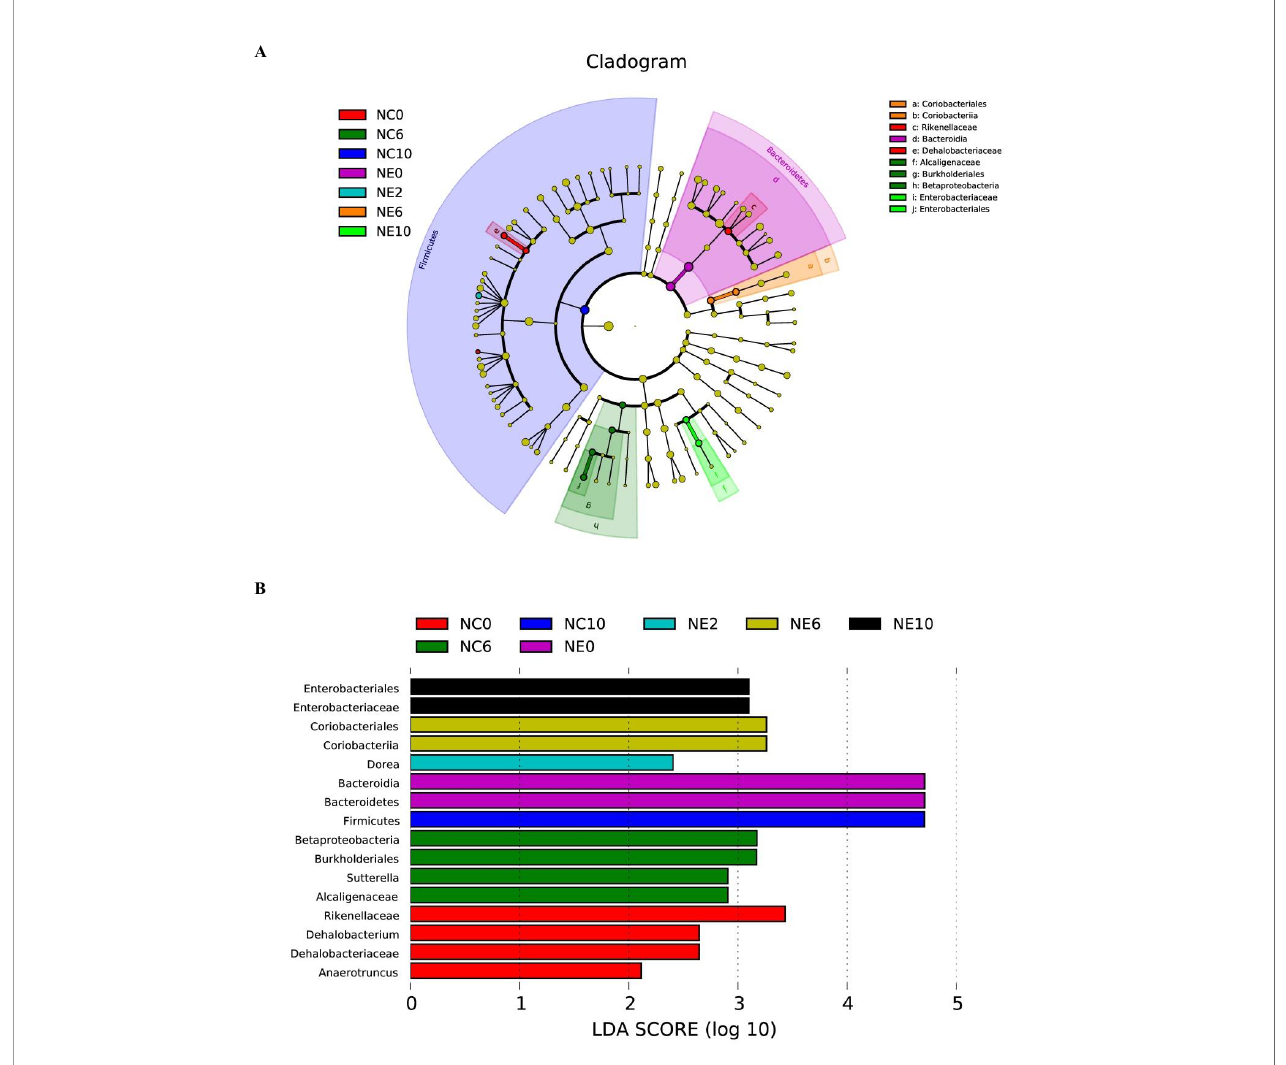
FIGURE 10 | Linear discriminant analysis effect size. LEfSe was used to fi nd the biomarker of inter-group difference. (A) shows the distribution of LDA values of different species. The colors represent groups. The length of the bar chart represents the contribution of different species (i.e., LDA Score). (B) shows the evolutionary clade of different species. The radiating circle from inside to outside represents the classi fi cation level from phylum to genus (or species).Each small circle at a different classi fi cation level represents a classi fi cation at that level, and the diameter of the small circle is proportional to the relative abundance. Coloring principle: species with no signi fi cant difference are uniformly colored in yellow, and different species are colored with the